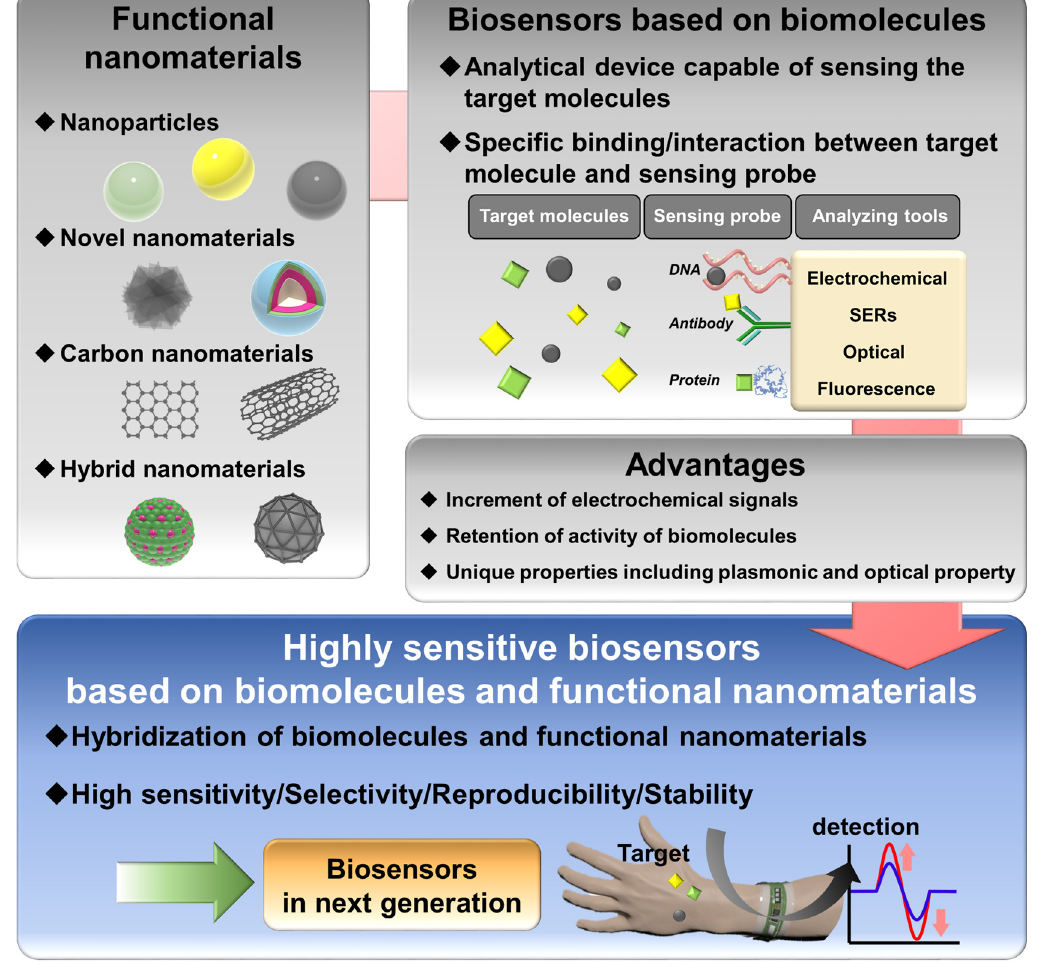
Figure 1. Highly sensitive biosensors based on biomolecules and functional nanomaterials.